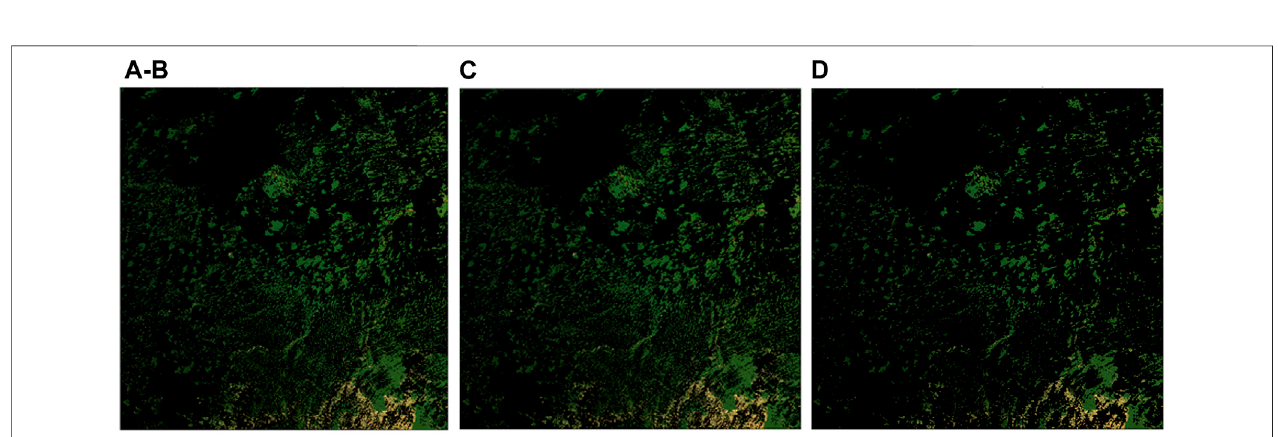
FIGURE 3 | MCD19A1 QA fi ltering for the scene in Figure 2 : (A) RGB MCD19A1 SR, no QA; (B) added “ Algorithm Initialized Status ” ; (C) added “ AOD level ” ; (D) added “ Adjacency Mask ” fi lter.